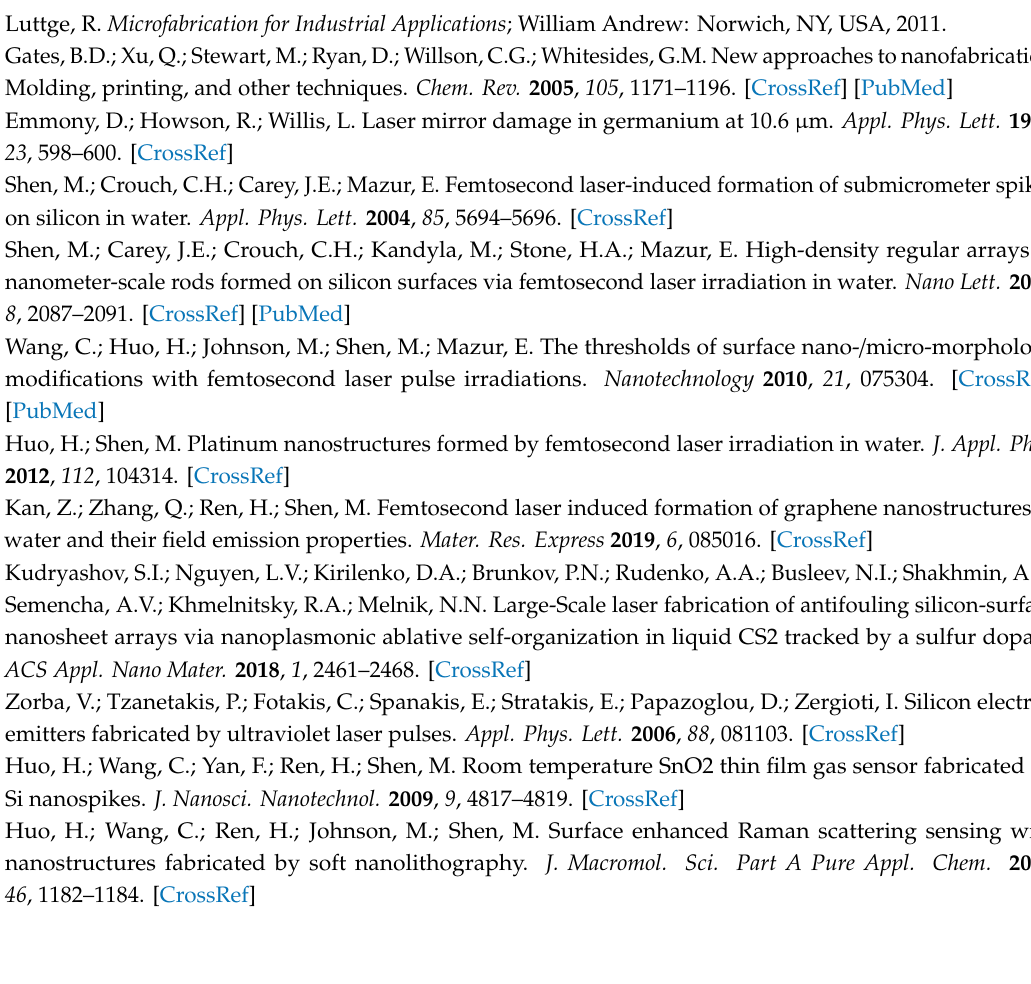
Figure S1: Top view FESEM image of silicon foil with continuum beam scan in